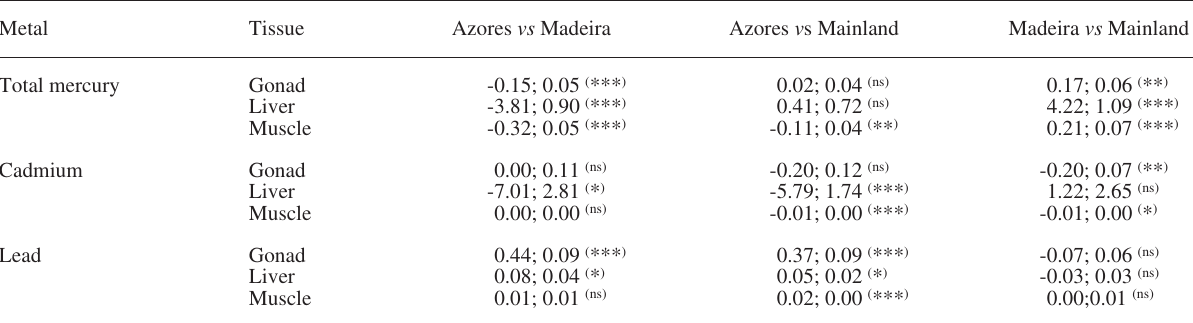
Table 4. – Multiple comparisons between total mercury, cadmium and lead estimated marginal means by region for each tissue (mean differ- ence; standard error; significance of